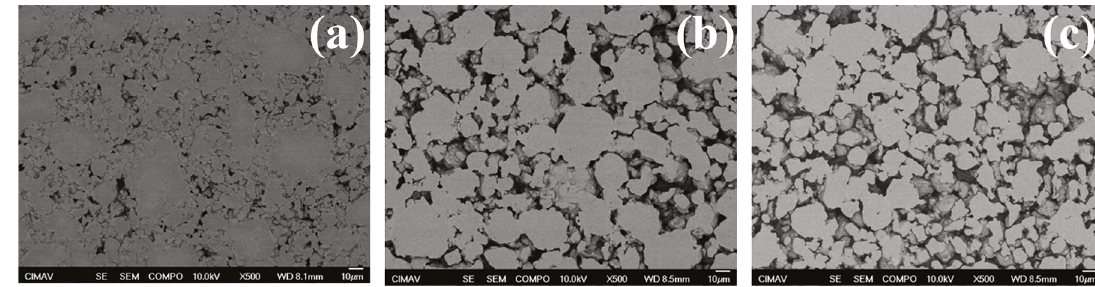
Figure 6: SEM images of sintered NiCoAlFeCuCr alloys as a function of the milling time: a) 10, b) 20 and c) 30 h.